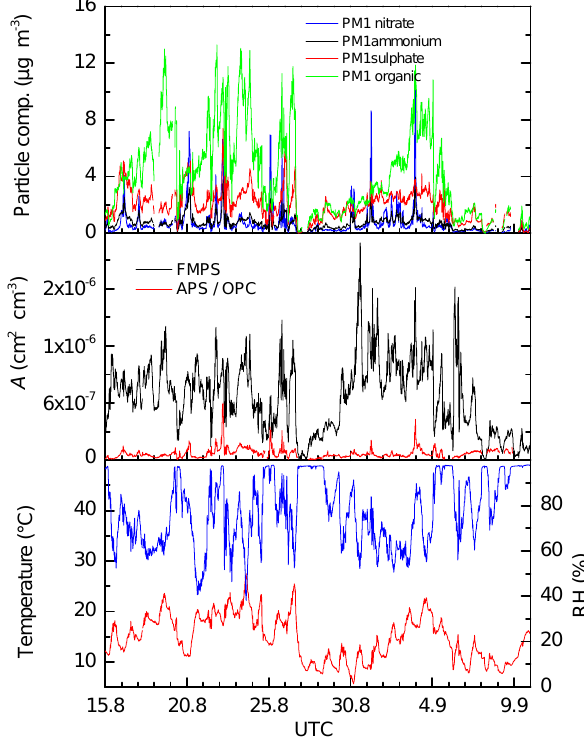
Figure 2. Time series of temperature, relative humidity and par- ticle properties during PARADE. A is aerosol surface area. Non- refractory, PM 1 organic, nitrate, sulfate and ammonium were mea- sured by the AMS. Aerosol surface area was measured by an FMPS (20–500nm) and by APS ( > 0.5µm) and OPC ( >